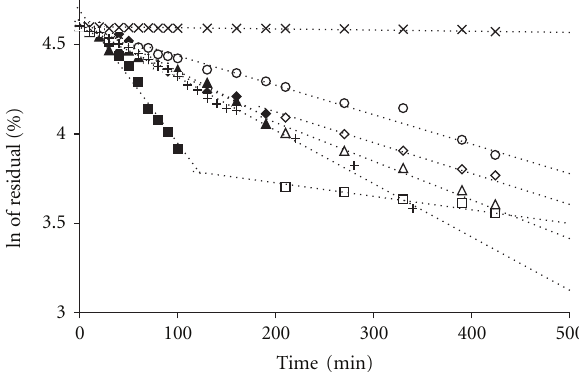
Figure 4: Influence of the type of polymer on the release kinetics of CX from the polymeric bead at 22 ◦ C. The release from respective preparations was depicted as follows: pNIPAM-A-CX for first stage ( (cid:2) ) and second stage ( ♦ ), pNIPAM-B-CX for first stage ( (cid:3) ) and second stage ( (cid:6) ), pNIPAM-C-CX for first stage ( (cid:4) ) and second stage ( (cid:7) ), MC-CX ( ◦ ), PA-CX ( × ), and aqueous dispersion of CX (+), data from repeated six